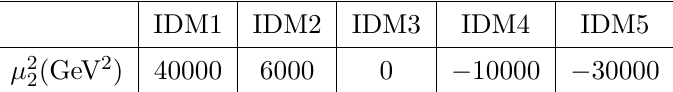
Table 3 . In Scenario I, typical values of µ 2